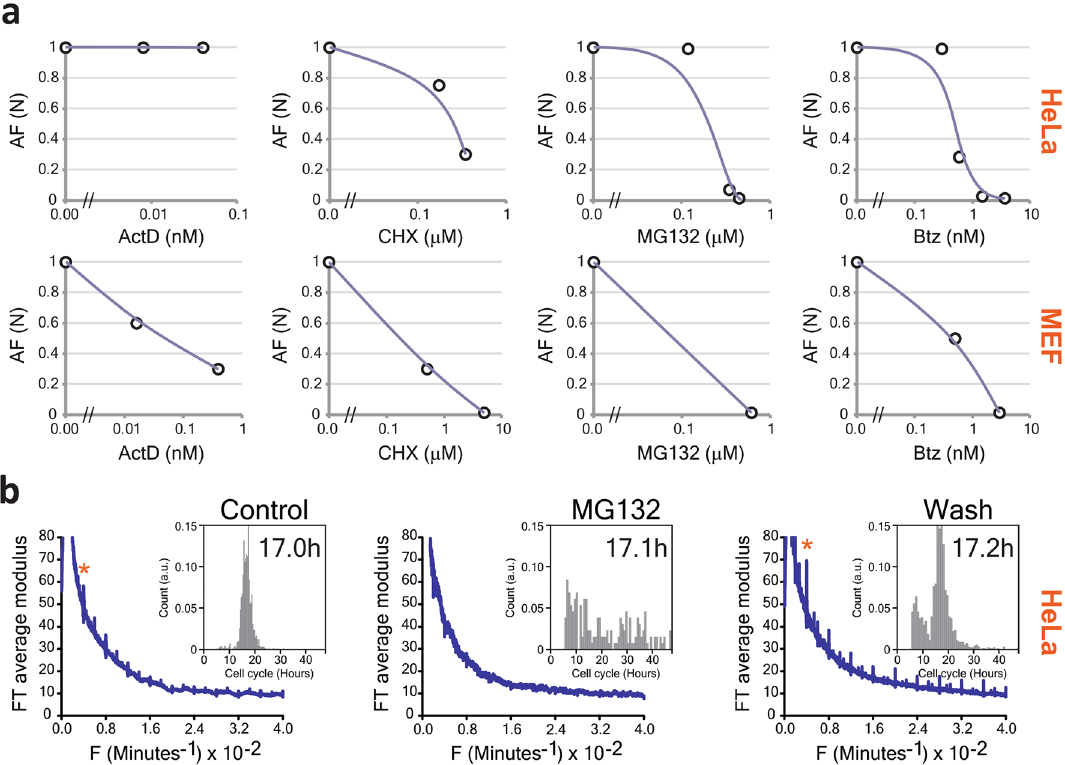
Figure 4. Effect of different inhibitors on the rhythm. ( a ) Effect of different inhibitors on the rhythm measured by the amplitude of the fundamental peak at 0.004 min −1 in Hela (first row) and MEF (second row). ( b ) Inhibition of the 4 h rhythm by MG132 is reversible. Compared to control conditions (left panel), treatment of HeLa cells with 0.45 μM of MG132 for 24 h completely suppressed the rhythm (middle panel). Subsequent removal of the MG132 by rinsing restored the oscillations with increased amplitude (right panel). The inserts show the distributions of the cell cycle